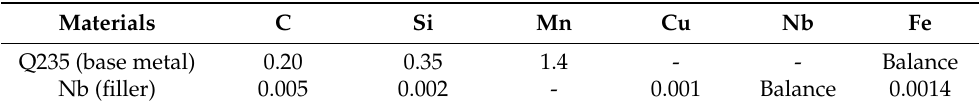
Table 1. Chemical compositions of materials used